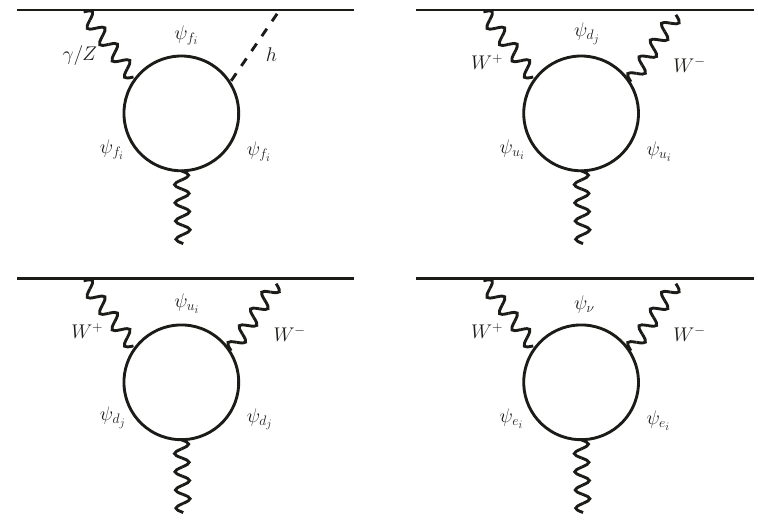
2 : 9 10 (cid:0) 26 e cm [86]) and the future prospects d n j j (cid:21) (cid:2) (cid:1)